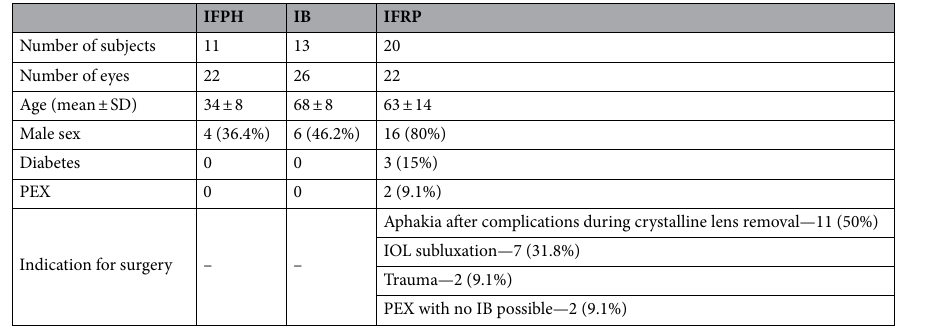
Table 1. Background demographics of the study population.